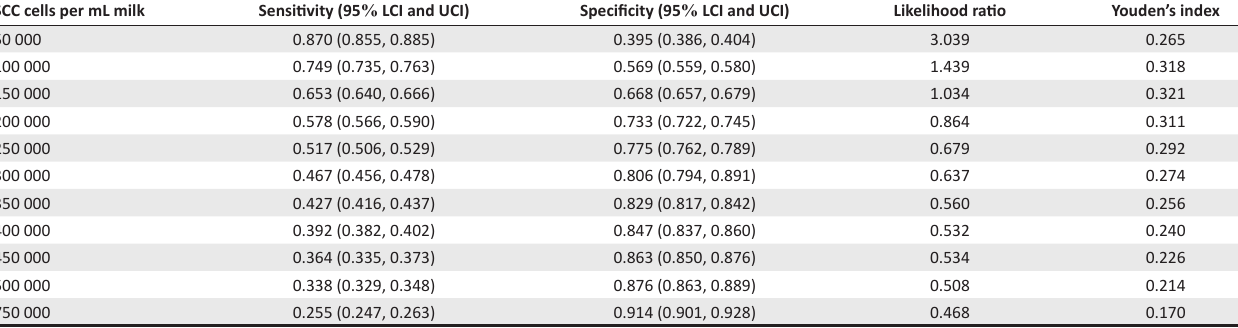
TABLE 2: Analysing intramammary infection in composite milk samples at different somatic cell count thresholds. SCC cells per mL